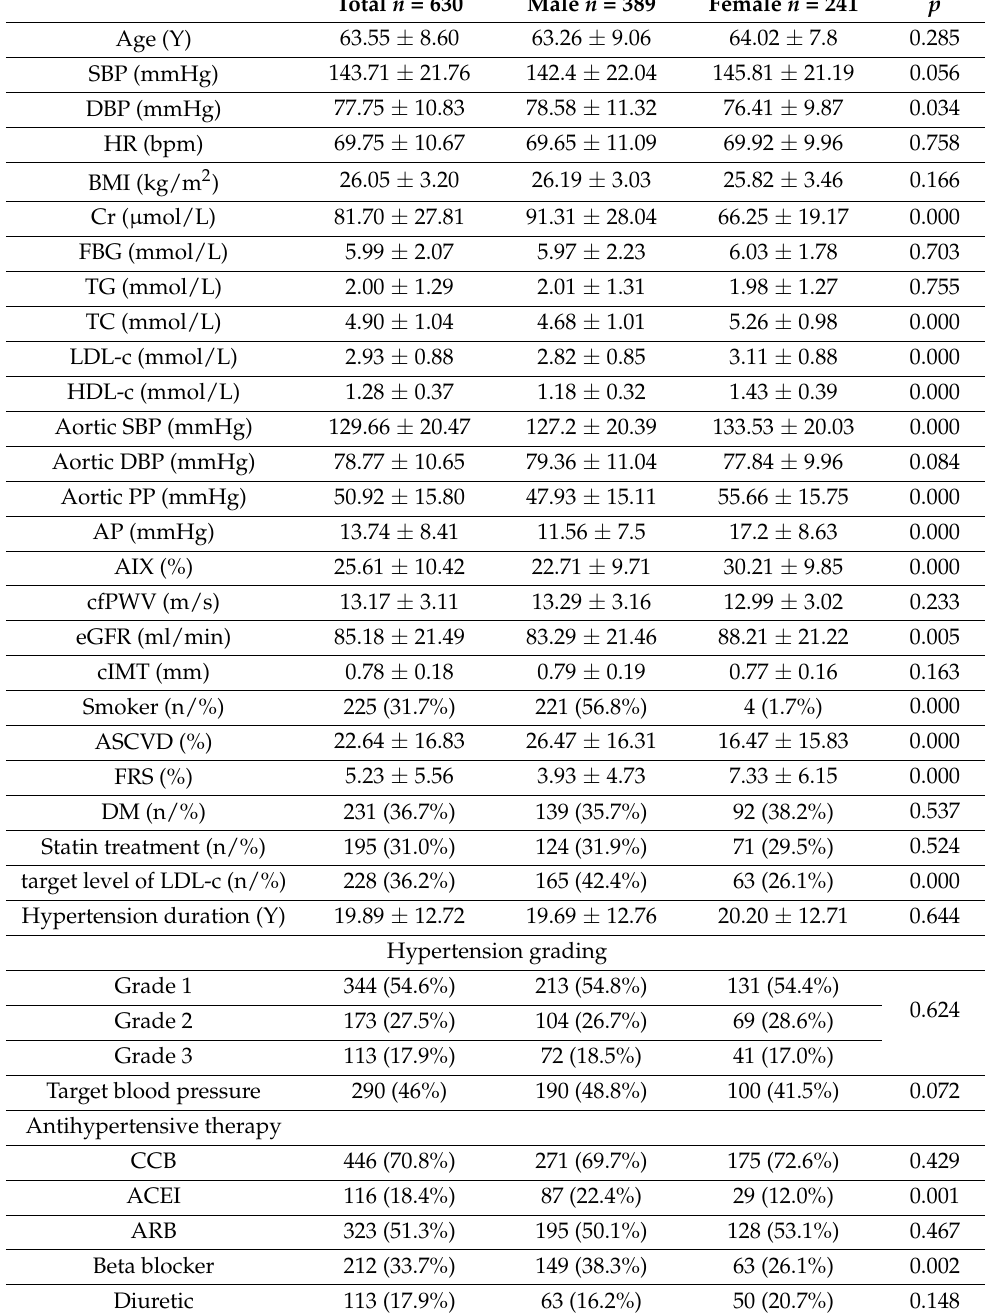
Table 1. General characteristics of the study population.